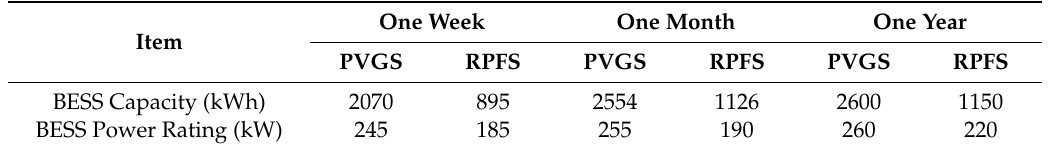
Figure 12. Seven-day load profiles for 50% PV penetration with PV and BESS for RPFS (1–7 January 2016). Figure 12. Seven ‐ day load profiles for 50% PV penetration with PV and BESS for RPFS (1–7 January 2016). Table 3. Comparison of the duration of study for BESS Figure 12. Seven ‐ day load profiles for 50% PV penetration with PV and BESS for RPFS (1–7 January 2016).